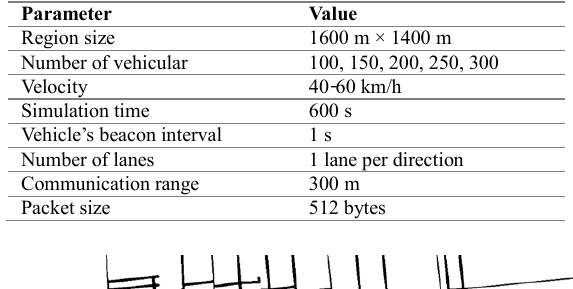
Table 1. Simulation parameters. Parameter